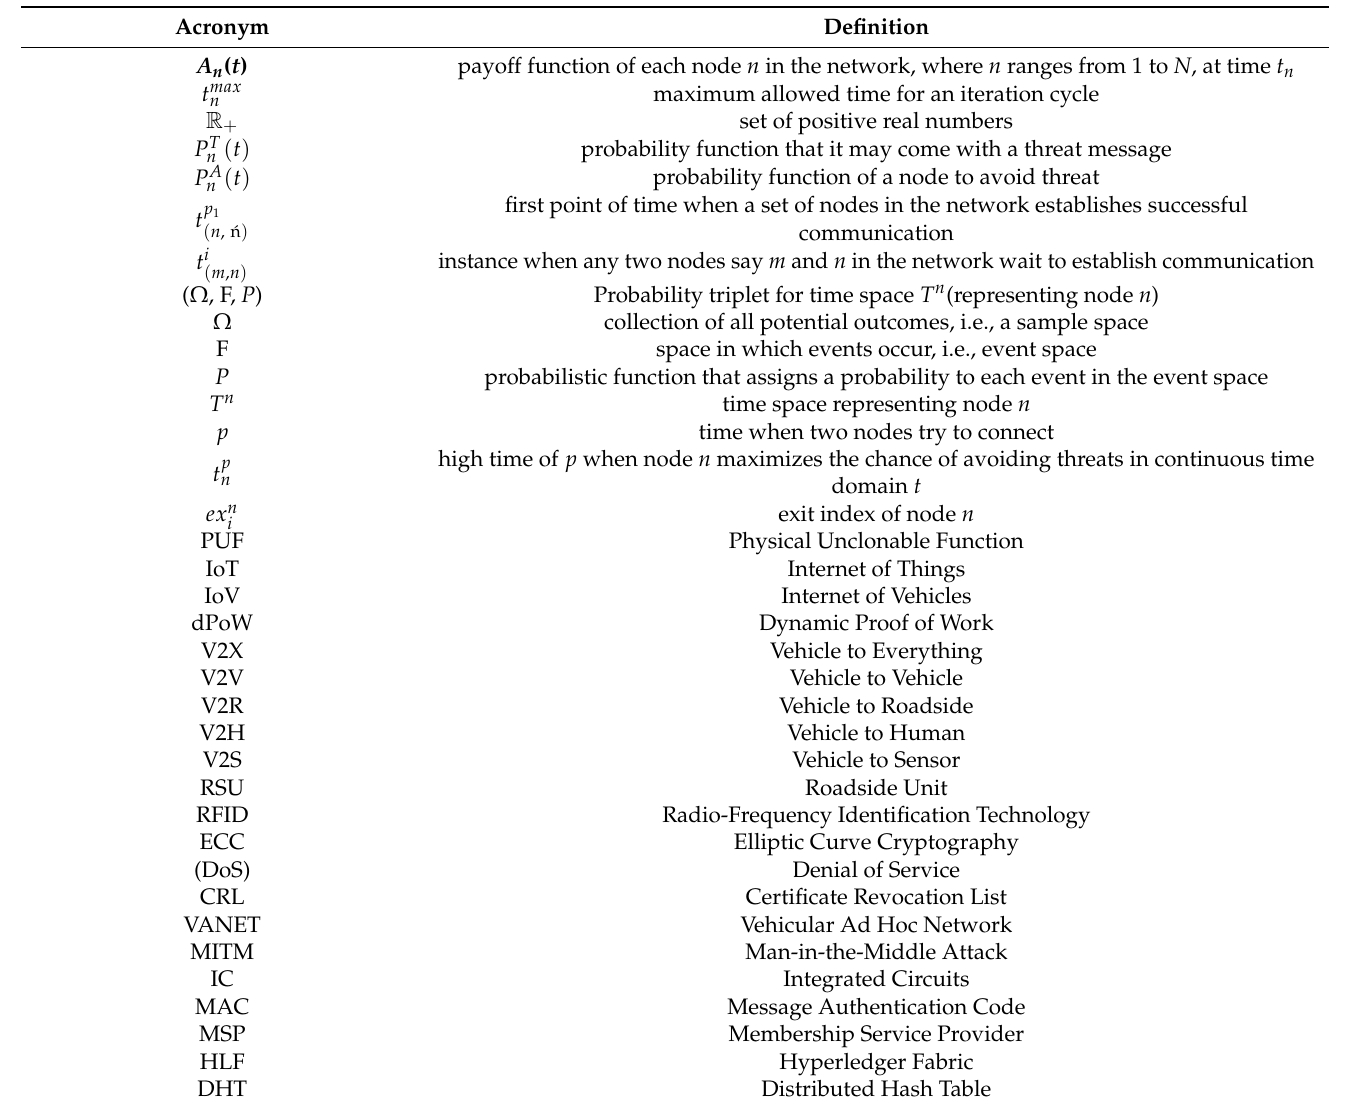
Table 2. Acronyms Used in This